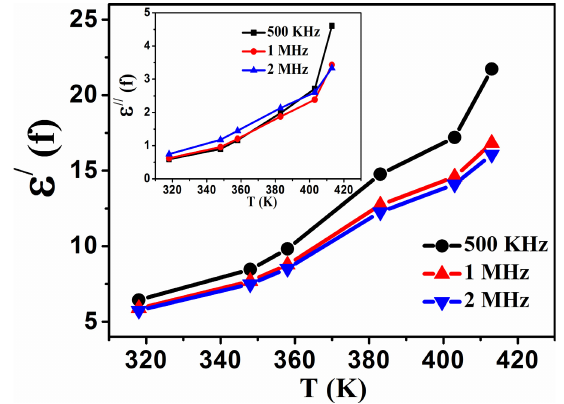
Figure 6: The temperature variation of real part ( ε ′ ) of dielectric constant of the sample at different frequencies (inset shows the temperature variation of imaginary part ( ε ′′ ) of dielectric constant at different frequencies).